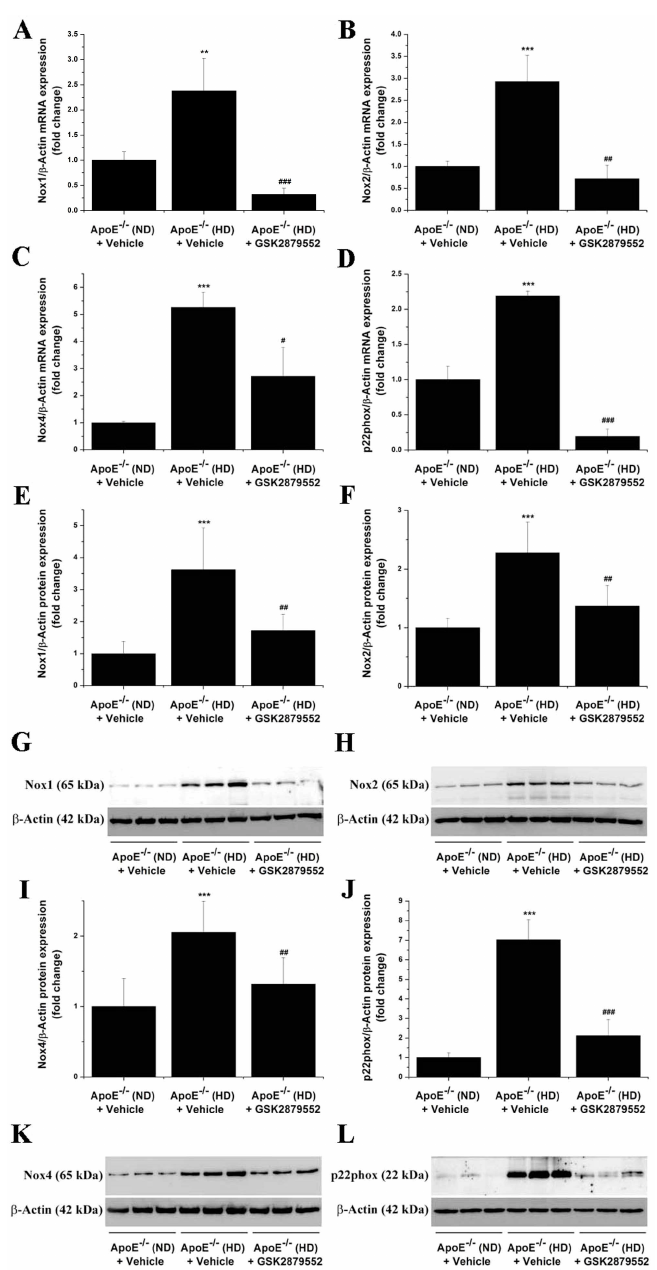
Figure 6. Long-term pharmacological inhibition of LSD1 activity prevents the up-regulation of Nox subunit gene and protein expression levels in the atherosclerotic aorta of ApoE-/- mice. ( A – D ) Gene expression analysis showing the suppressive effects of GSK2879552 on Nox1, Nox2, Nox4, and p22phox mRNA levels in the aorta of hypercholesterolemic ApoE -/- (HD) mice. ( E , F , I , J ) Western blot assay- associated densitometric analysis indicating that the relative protein abundance of each Nox subunit is significantly decreased in the aorta of GSK2879552-treated ApoE-/- (HD) mice as compared with vehicle-treated ApoE-/- (HD) mice. ( G , H , K , L ) Representative immunoblots showing the labeling of the Nox subunit proteins at the predicted molecular weight and the regulation of Nox subunit protein levels in the aorta of each animal group. n = 3–6, ** p < 0.01, *** p < 0.001. p -values were taken in relation to vehicle-treated ApoE-/- (ND) condition. # p < 0.05, ## p < 0.01, ### p < 0.001. p -values were taken in relation to vehicle-treated ApoE-/- (HD)